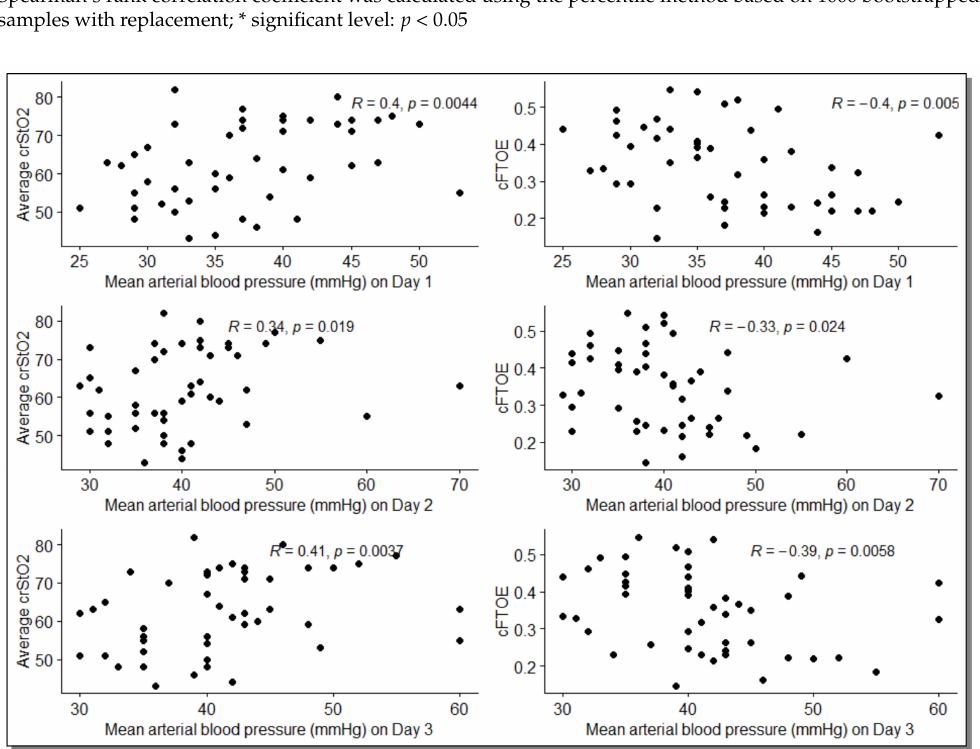
Figure 1. Scatter plots between the mean arterial blood pressures measured in the first 3 days and crSaO 2 and cFTOE; R = Rho (Spearman’s rank correlation